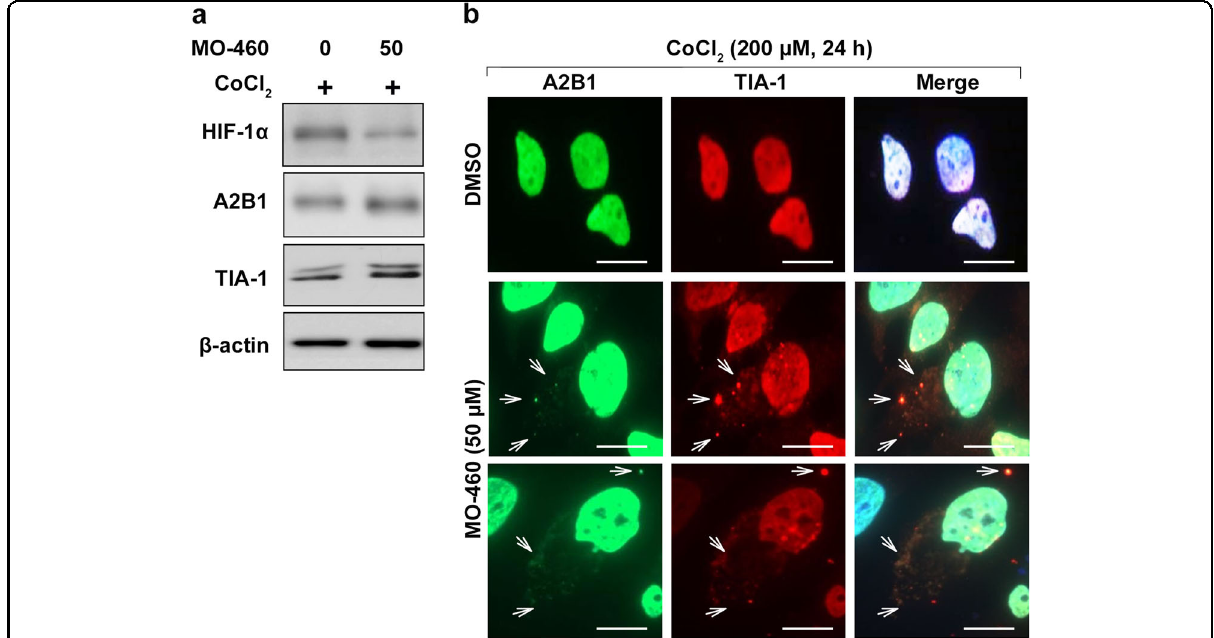
Fig. 6 Inhibitory effect of MO-460 on HIF-1 α protein translation is via stress granule formation. a Western blotting of indicated antibodies in Hep3B cells under mimetic hypoxia and the presence or absence of MO-460. b Immunostaining of cells grown under mimetic hypoxia described using anti-hnRNPA2B1, anti-TIA-1(red) and nuclei stain (blue). Scale bar, 20 μ